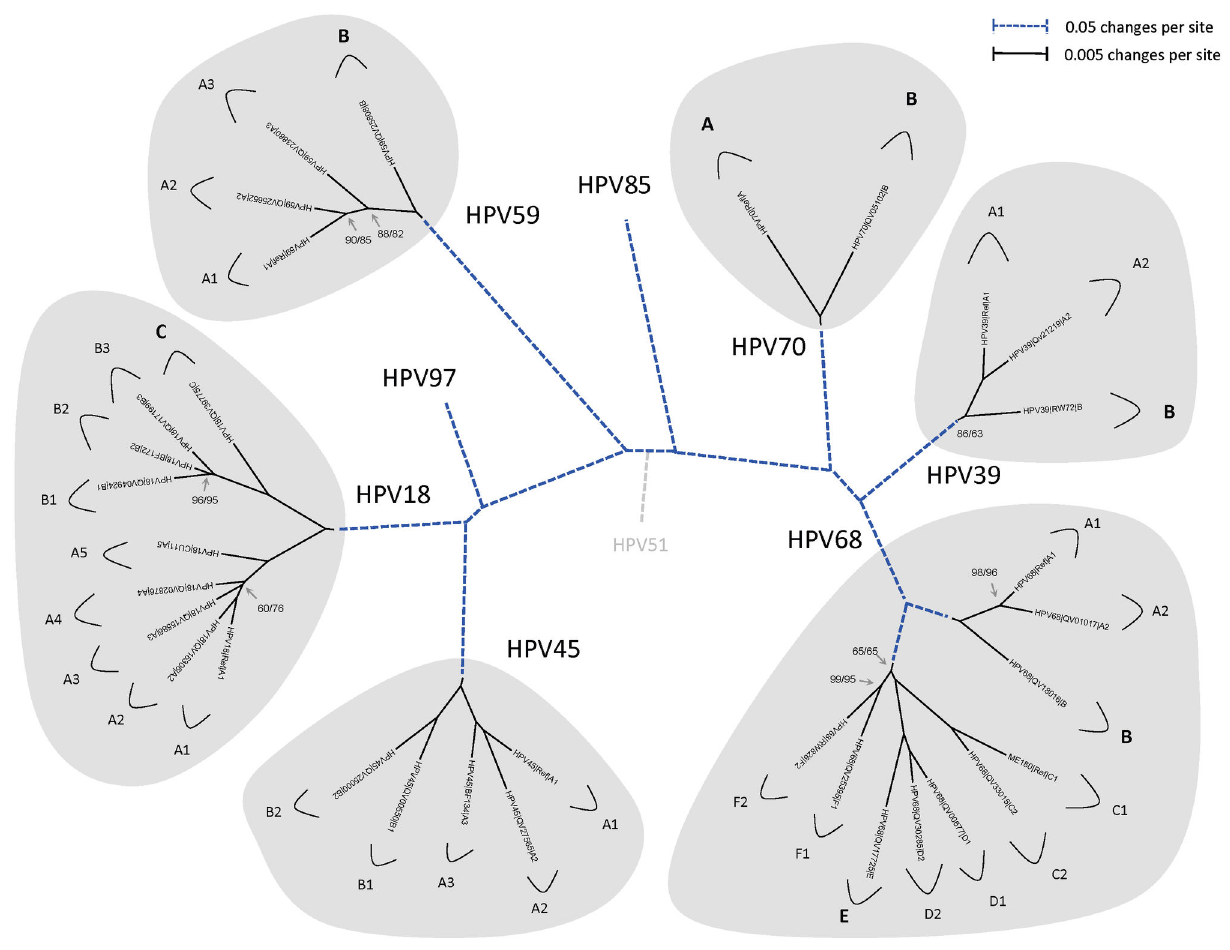
Figure 1. Alpha-7 phylogenetic tree showing representative types and variant lineages. A maximum likelihood (ML) tree was constructed using RAxML MPI v 7.2.8.27 [42] and PhyML MPI v 1.4.3 [43] inferred from the global alignment of complete circular genome nucleotide sequences linearized at the first ATG of the E1 ORF. Numbers on or near branches indicate support indices < 100% by RAxML and PhyML, respectively. The shaded areas represent groupings of lineages and sublineages of HPV18, HPV39, HPV45, HPV59, HPV68 and HPV70; the prototype sequences of HPV85 and HPV97 are also included as indicated, although no variant lineages are distinguished due to the limited number of isolates of these types. The length of broken and solid lines represent distance between clades, although the number of changes is different for these two lines, as indicated in the upper left corner of the figure. HPV51, an alpha-5 type, was set as the outgroup. doi: 10.1371/journal.pone.0072565.g001 genome sequencing (Table 1 and Table S1). The overall nucleotide and amino acid variable positions of the complete genomes (19 sequenced for this analysis plus the reference sequence makes a total of 20 complete genomes) were 2.4% (186 sites among 7912 nt) and 2.5% (61 sites among 2428 aa), respectively. The noncoding regions (NCR2 and URR) were more variable than the coding ORFs. HPV39 isolates Tw562 and BF182 were the most distantly related genomes with a nucleotide sequence pairwise difference of 1.1%; this distance represented the maximum inter-lineage diversity of HPV39 variants (Table S2). Phylogenetic